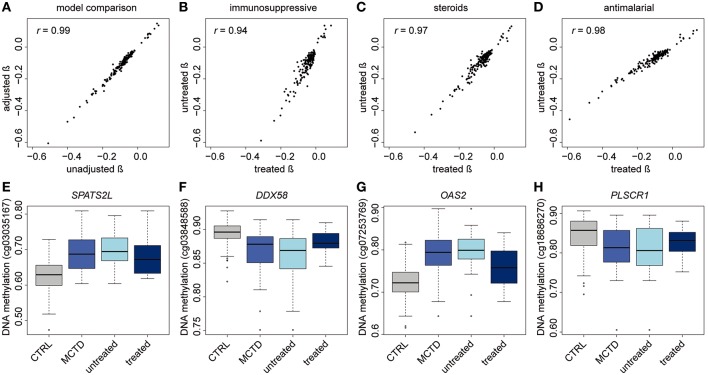
Treatment effects on the MCTD epigenetic associations. (A–D) Effect size correlation plots to compare results from different models. (A) In the x-axis results from linear models in which the treatments are not included as covariates are depicted. In the y-axis results from linear models in which treatments are included as covariates are depicted. (B–D) Effect size comparisons for treatment-stratified analyses comparing effect sizes in the treated sample and in the untreated sample. (E–H) Boxplots for immunosuppressive specific epigenetic signals. DNAm levels are illustrated in controls, MCTD cases, untreated MCTD cases and treated MCTD cases in different CpG sites.